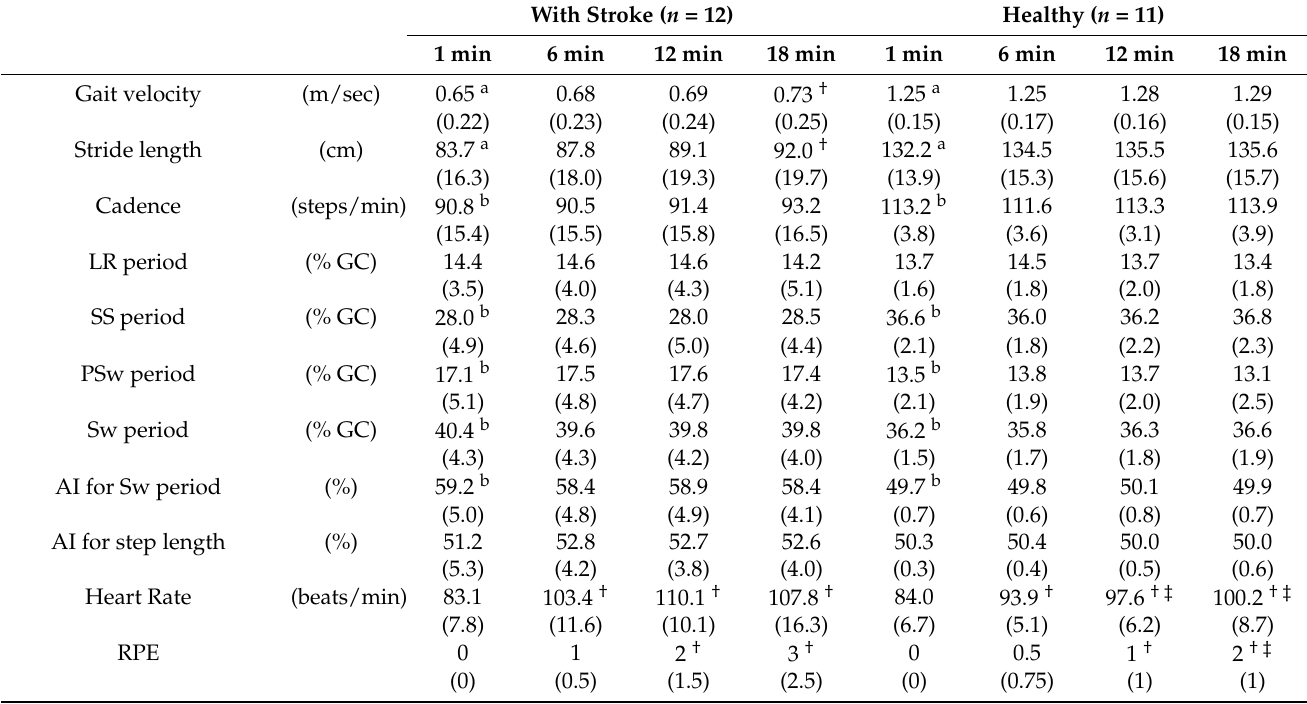
Table 2. Gait performance changes over time during the extended walk